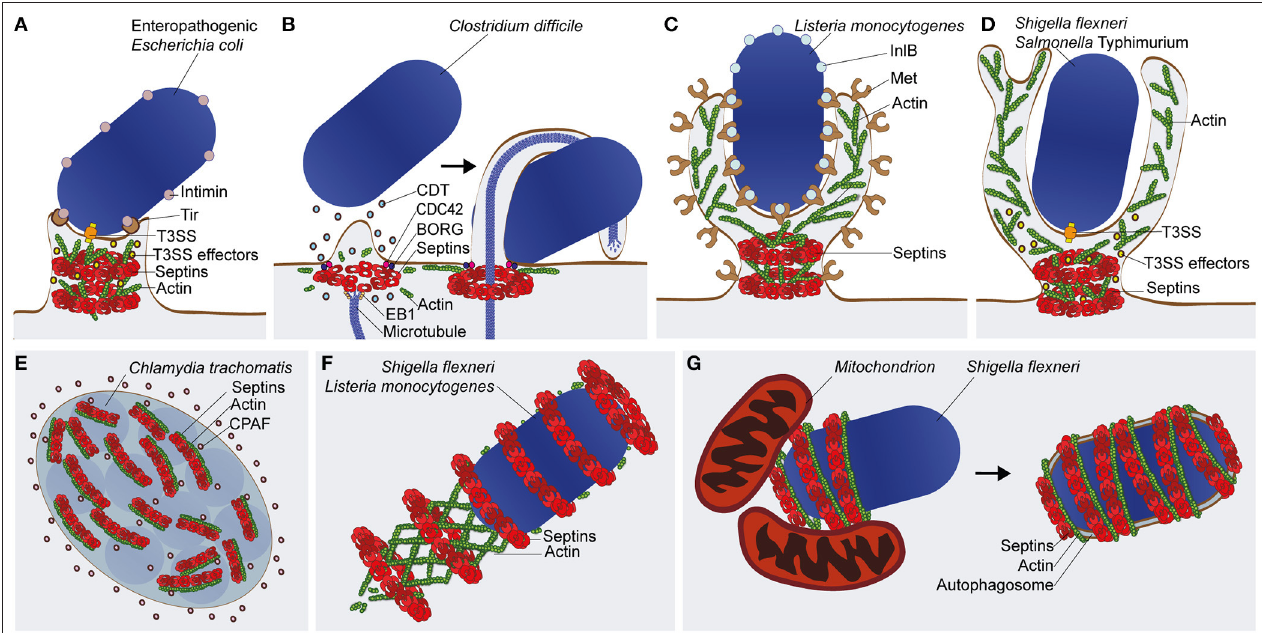
FIGURE 2 | Septin recruitment and function in bacterial infections. (A) The enteropathogenic E. coli (EPEC) pedestal. Type 3 secretion system (T3SS) effectors of EPEC are implicated in septin phosphorylation and assembly into filaments and rings. It is proposed that septins assemblies (depicted here as rings) remodel cortical actin for pedestal biogenesis (B) The C. difficile microtubule-based protrusion. Intoxication with the C. difficile toxin (CDT) leads to patches of cortical actin/septin depolymerization followed by rearrangement of septins into ring-like structures, facilitated by the factors Cell Division Control Protein 42 (CDC42) and Binder of Rho GTPase (BORG). By interacting with End Binding 1 (EB1) protein, septins redirect microtubule polymerization and initiate protrusion formation. Protrusions prevent the mechanical clearance of C. difficile by wrapping around the bacterium. (C) Zipper-mediated entry by L. monocytogenes . During invasion of Listeria into host cells, interaction of the virulence factor Internalin B (InlB) with its membrane receptor Met, initiates septin recruitment to the entry site where it forms ring-like structures at the base of the phagocytic cup. (D) Trigger-mediated entry by S. flexneri or S. Typhimurium. Septin ring-like structures associate with the bacteria upon injection of T3SS effectors into the host cell to induce membrane ruffles and macropinocytosis at the bacterial entry site. In the case of (C,D) , septins at the plasma membrane may facilitate actin remodeling, membrane protrusion, and bacterial internalization by acting as diffusion barriers for lipids and signaling molecules. (E) The C. trachomatis inclusion vacuole. Septin and actin filaments form a coat that associate with the cytosolic surface of the inclusion vacuole, and contributes to its remodeling to accommodate bacterial growth. The chlamydial enzyme CPAF is able to cleave septins for control of inclusion remodeling. (F) The L. monocytogenes or S. flexneri actin tail. Although dispensable for actin-based motility, septins assemble into rings around a subset of cytosolic bacteria polymerizing actin tails. The precise role of septins in the functionality of the actin tail remains unknown. (G) The S. flexneri septin cage. Septins assemble into cage-like